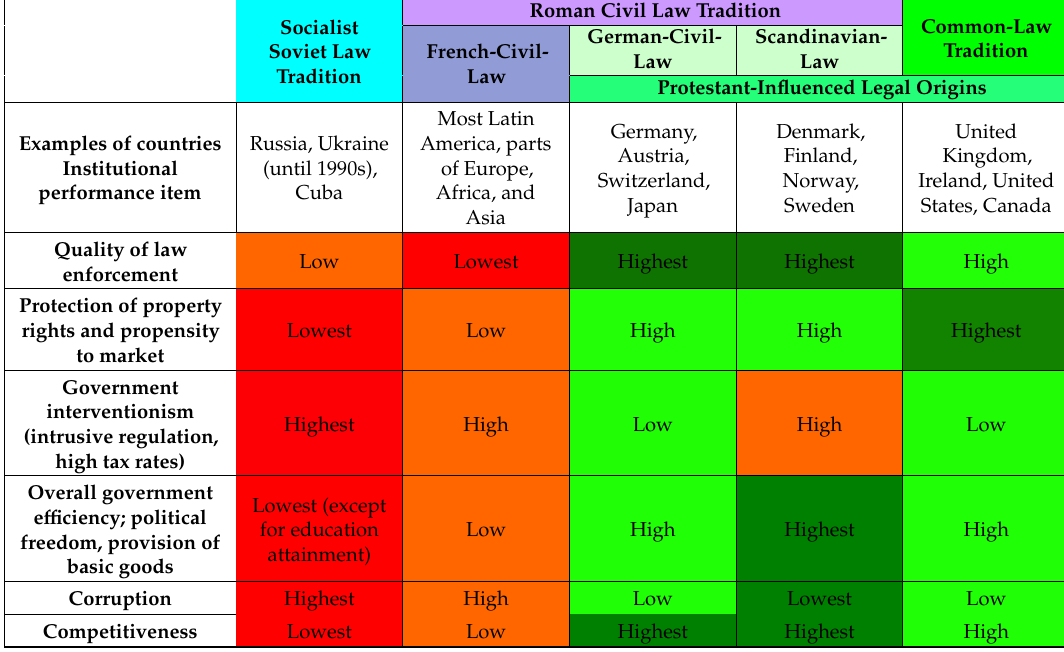
Table 3. Comparison of institutional performance between di ff erent legal traditions (La Porta et al. 1998, 1999, 2008; World Economic Forum 2014; Transparency International 2016; Berman 2003; Merryman and P é rez-Perdomo